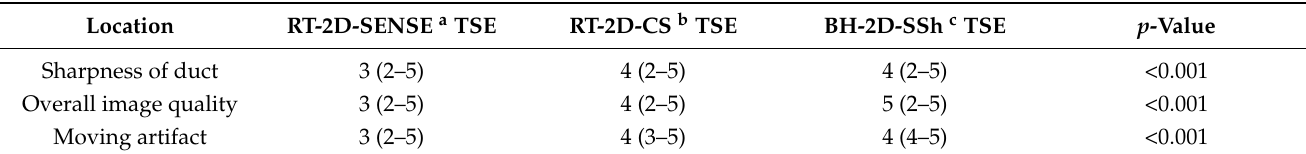
Table 4. Subjective grading of sharpness of duct, overall image quality, and motion artifacts in qualitative assessment ( n = 30).